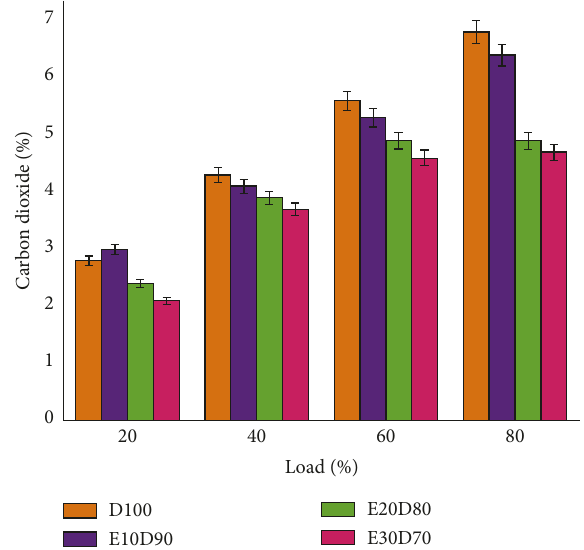
Figure 13: Variation in CO